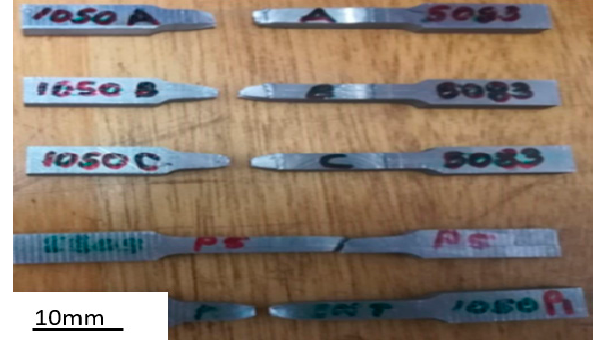
Figure 10. Fractured specimens.